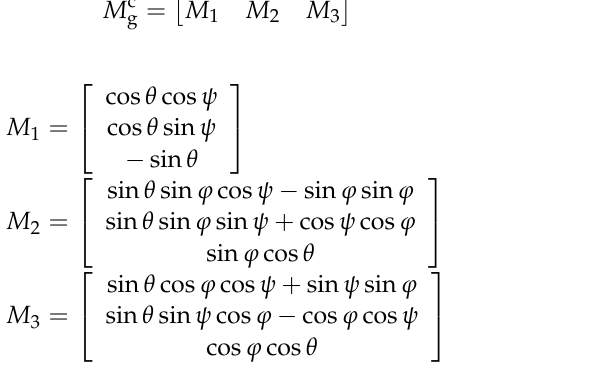
Figure 1. The coordinate reference frames of quadrotors. ZYX represent the coordinate transformation in the earth coordinate sys- ccc tem, represent three attitude angles, respectively. The position and attitude control of the quadrotor are confirmed in the structure g O , c M g